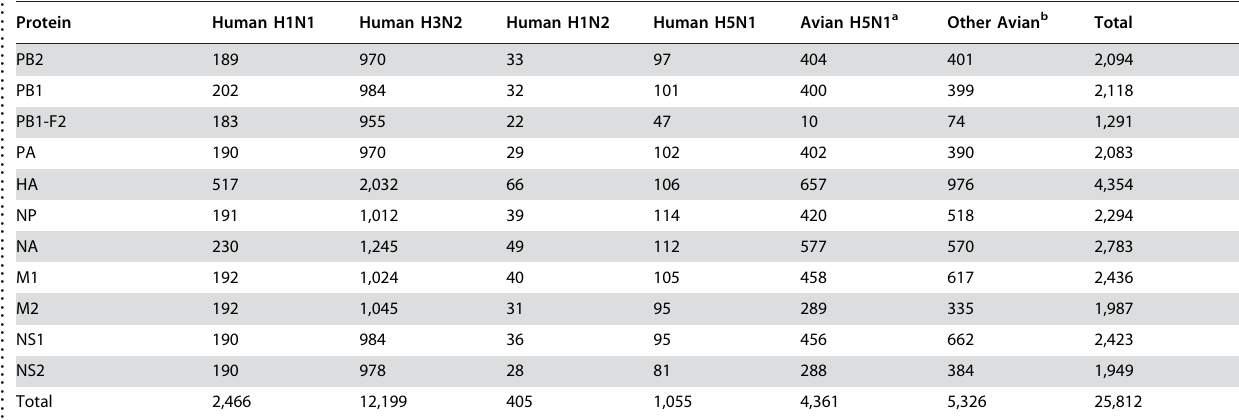
Table 1. Influenza types A virus protein sequences from the past decade (1997–2006).